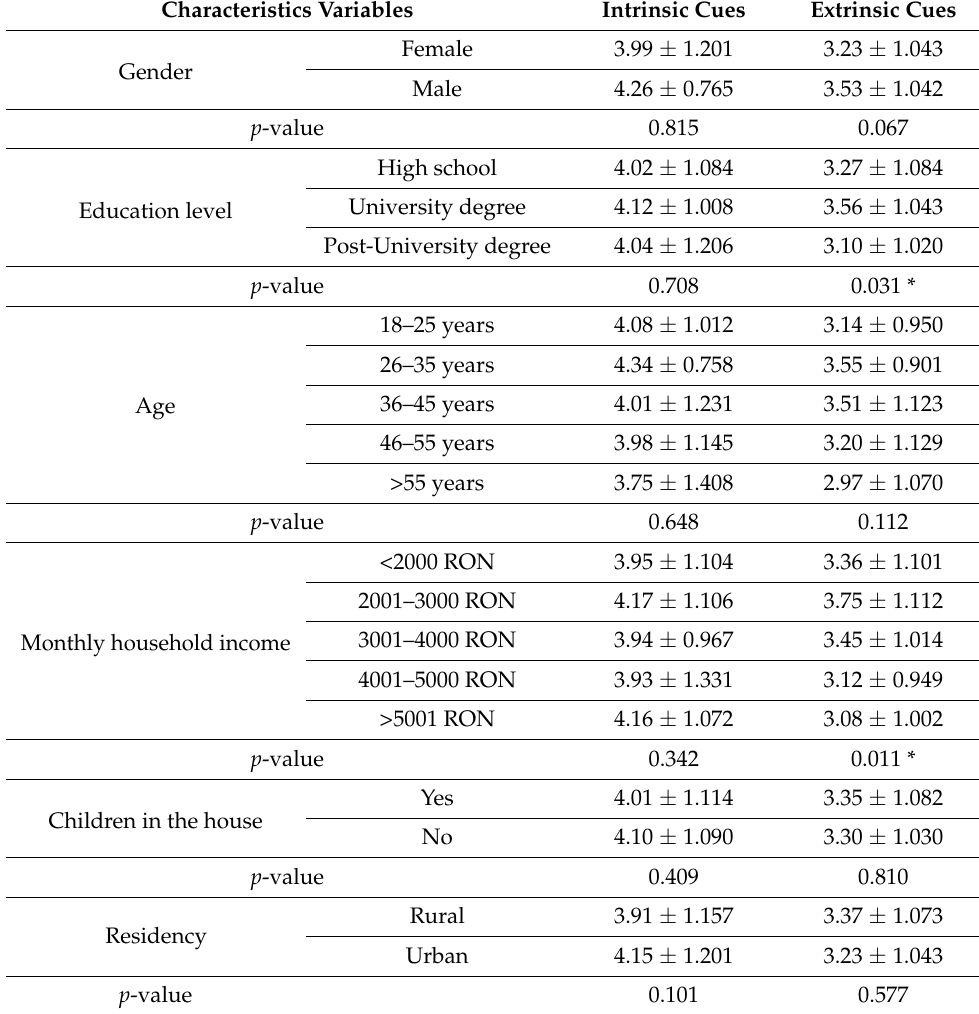
Table 3. Relationship between the socio-demographic characteristics of the respondents and the PCA. Characteristics